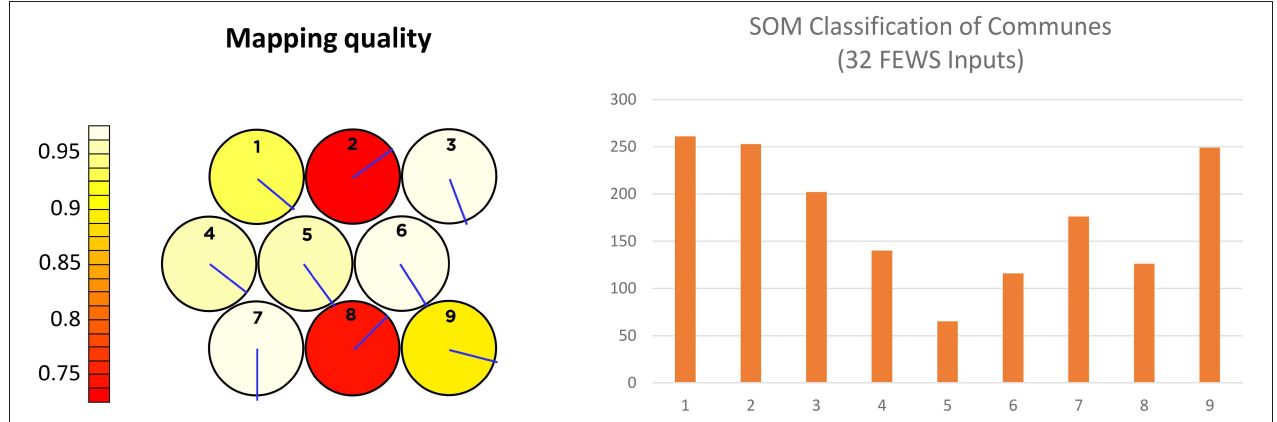
FIGURE 8 | Self-organizing Map (SOM) commune classifications and